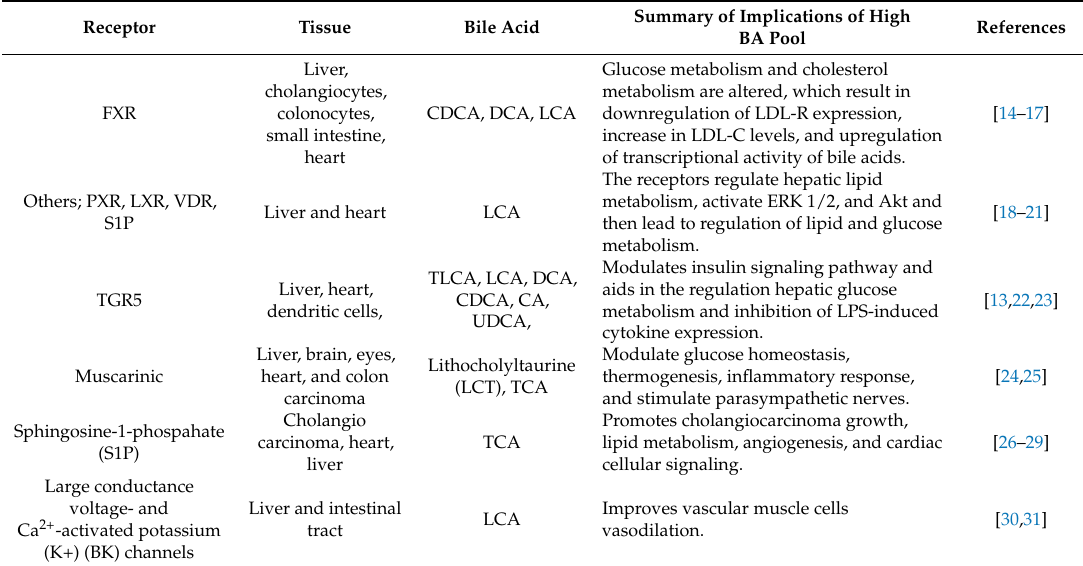
Table 1. The main receptor involved in bile acids